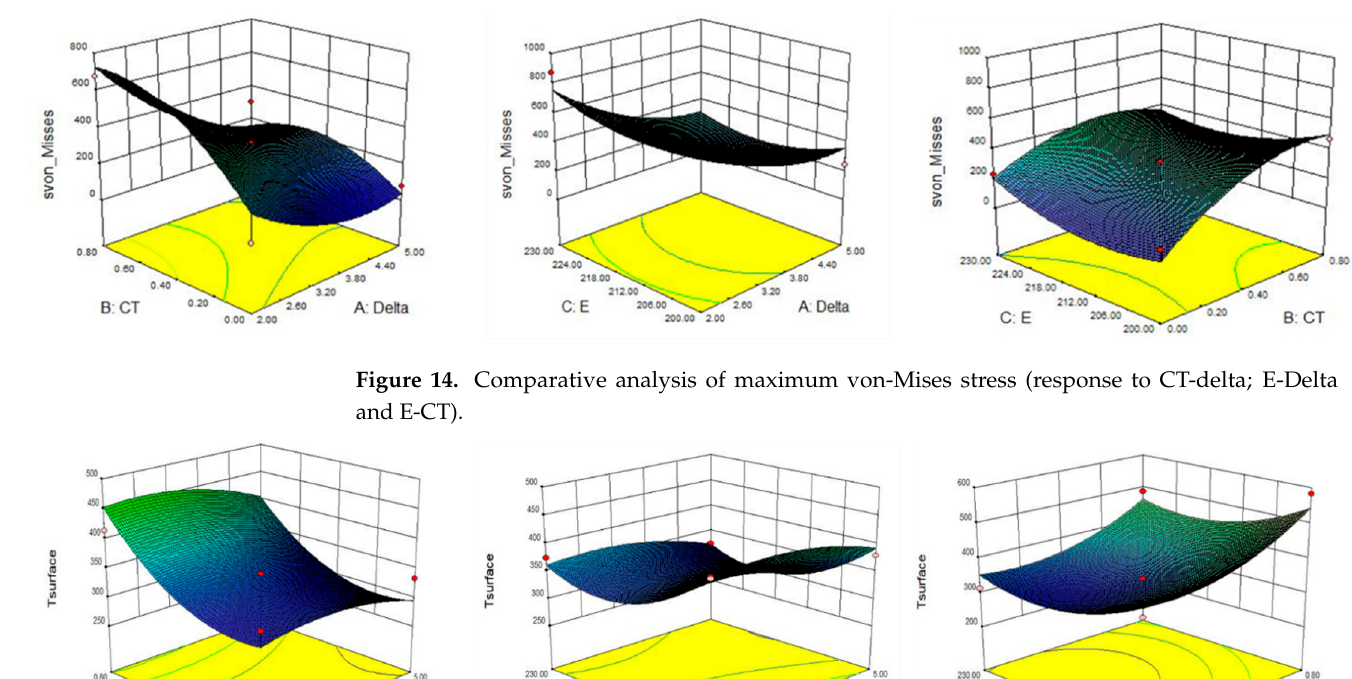
Figure 13. Comparative analysis of maximum elastic deformation (response to CT-delta; E-Delta and E-CT).